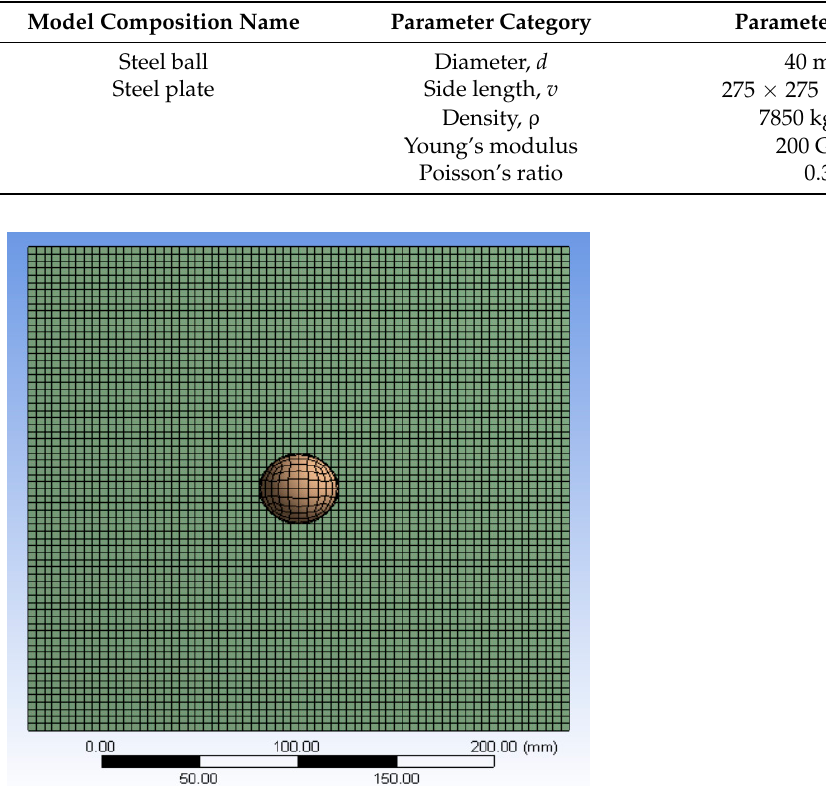
Detection point Steel plate